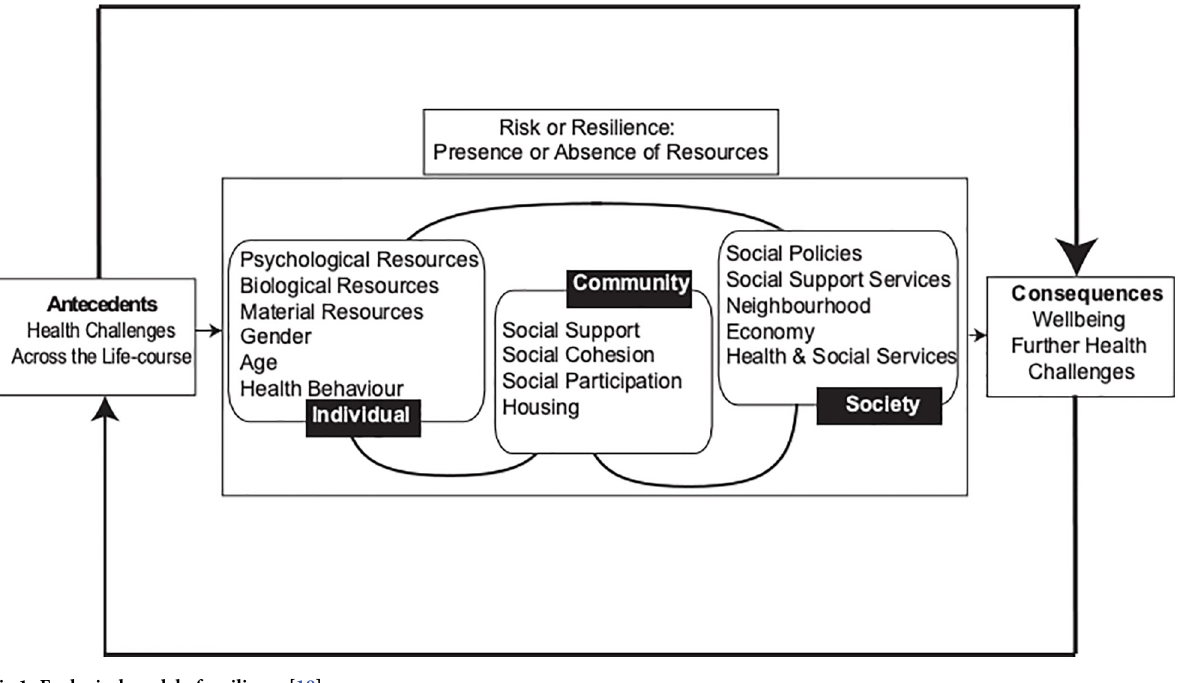
Fig 1. Ecological model of resilience